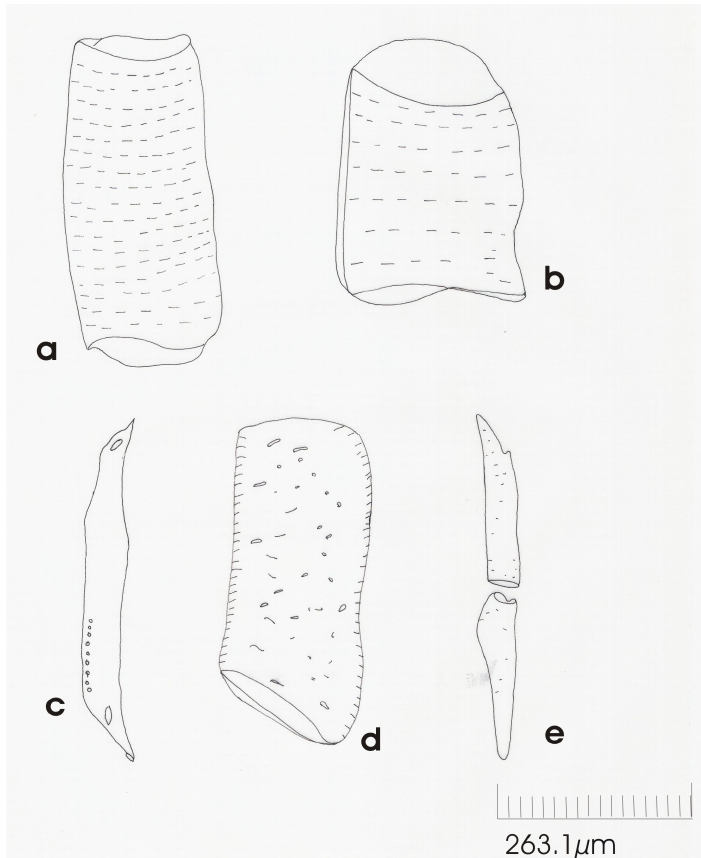
Fig. 7. Annona reticulata ; Vessel Members: wide vessels (a, b and d) and narrow vessels (c and e)